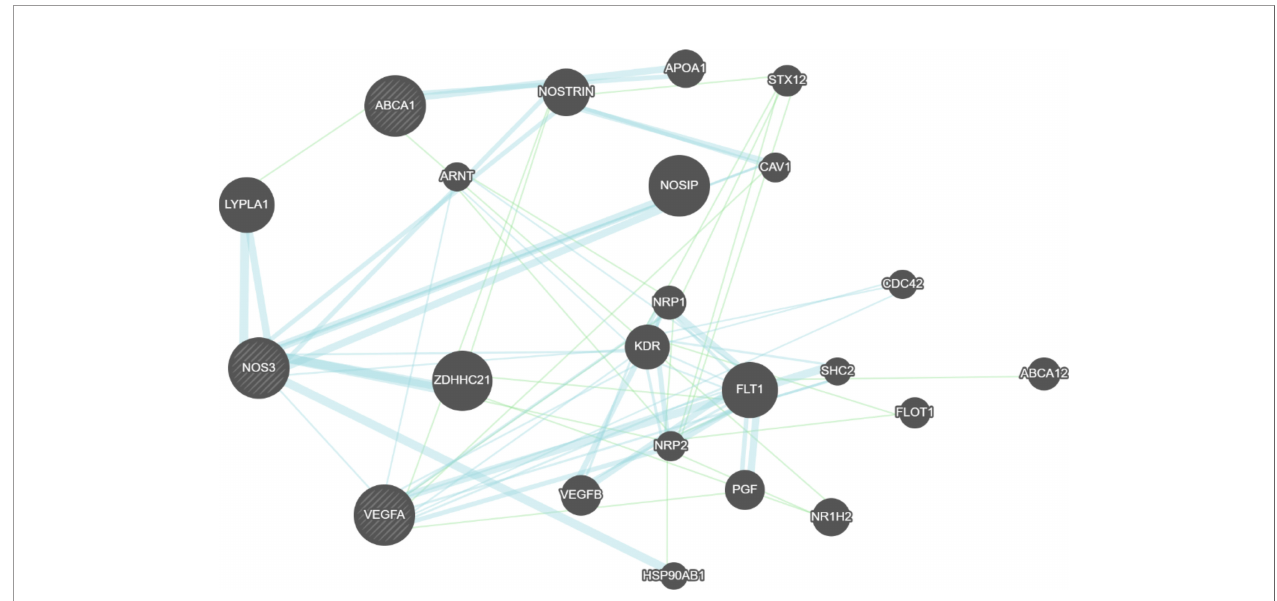
FIGURE 3 | Constructed interaction networks including all the genes related to the top SNPs associated with diabetic complications in this study. Black circles indicate the queried genes. Green lines represent the genetic interactions. Blue lines represent the protein-protein interaction.